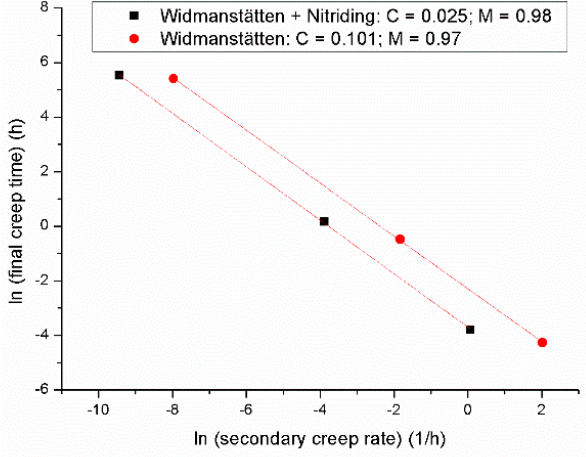
Figure 12. Secondary creep rate dependence for the applied stress of 319 MPa to plasma-nitrided Widmanstätten microstructure alloy as compared to data from Briguente [33] for untreated alloy.